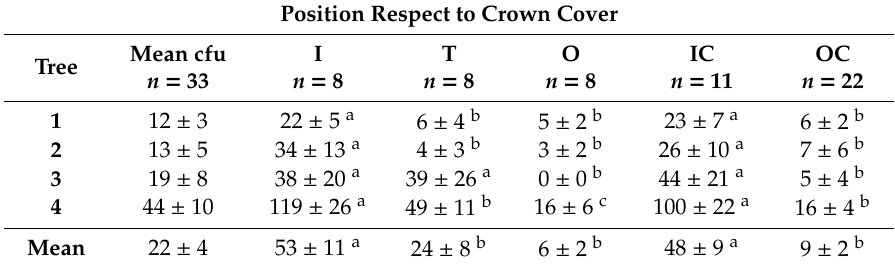
Table 1. Colony forming units of each tree (cfu sample − 1 , mean ± standard error) according to sample grid and sample position with respect to tree crown cover. Mean cfu: mean value of cfu considering all the samples; n : number of soil samples per grid under each tree; I: inside crown intensive grid; T: transition intensive grid; O: outside crown intensive grid; IC: all samples inside crown cover; OC: all samples outside crown cover. Di ff erent lowercase letters in superscript indicate significant di ff erences between position with respect to crown cover (Mann-Whitney U Test, P < 0.05 for IC-OC comparisons and P < 0.0167 for I-O-T comparisons). No comparisons were made between means corresponding to di ff erent factors (I, O and T with IC and